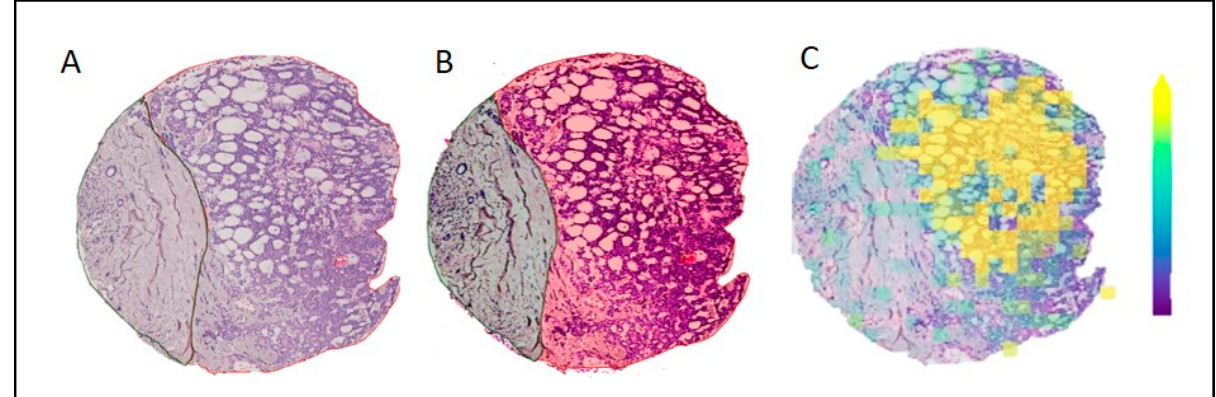
Figure 3. The distribution of a representative mass peak for AdCy in one TMA core and histological annotations. ( A ) Original H&E scan; ( B ) H&E scan overlayed with histopathological annotations (Green: Healthy connective tissue. Red: AdCy tumor tissue); ( C ) Relative intensity of mass 845.47321 m / z ± 3 mDa.